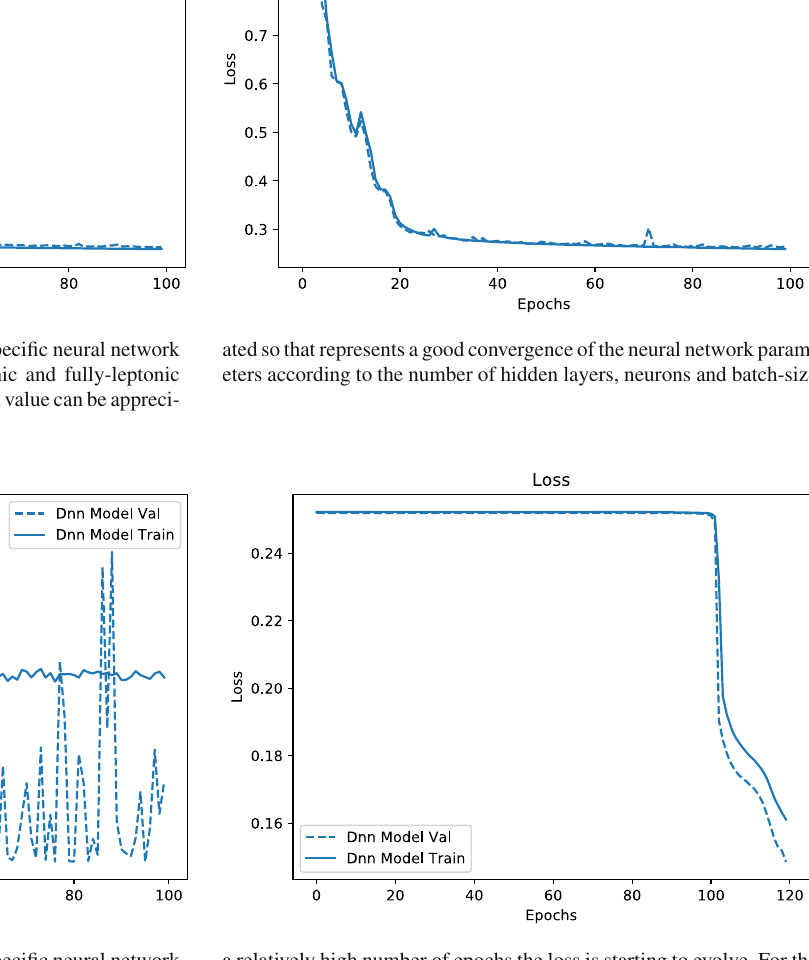
a relatively high number of epochs the loss is starting to evolve. For the optimal treatment of each particular convergence scenario an early stop automation can be employed so that the number of training epochs in each case can be tuned according to the learning rate and loss